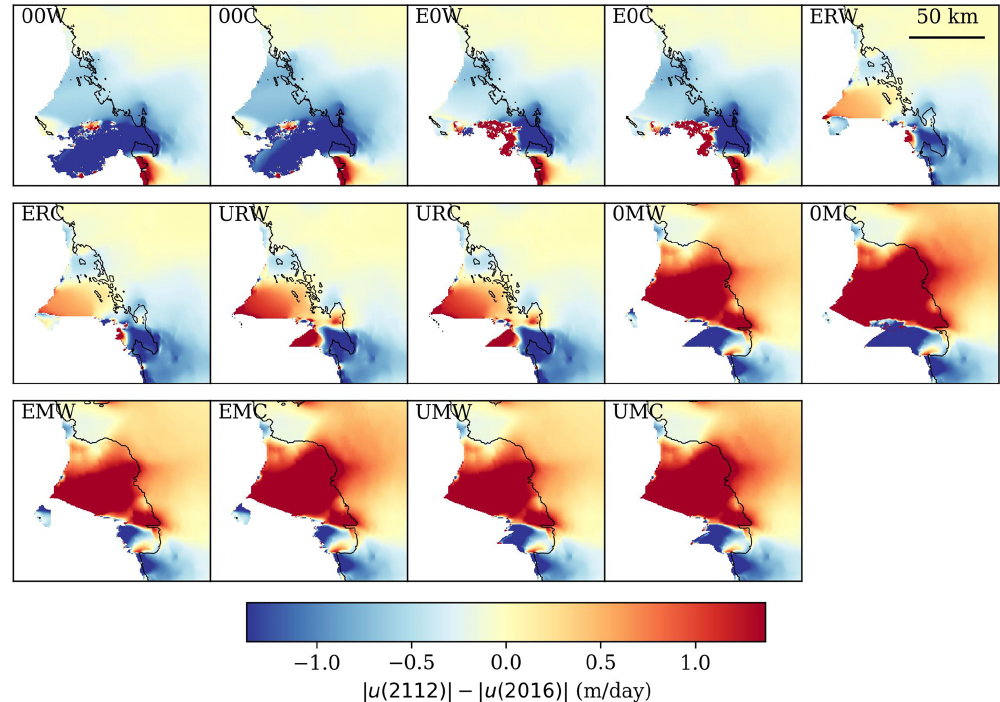
Figure A3. As Fig. 11, except showing differences in velocity between 2016 and 2112.